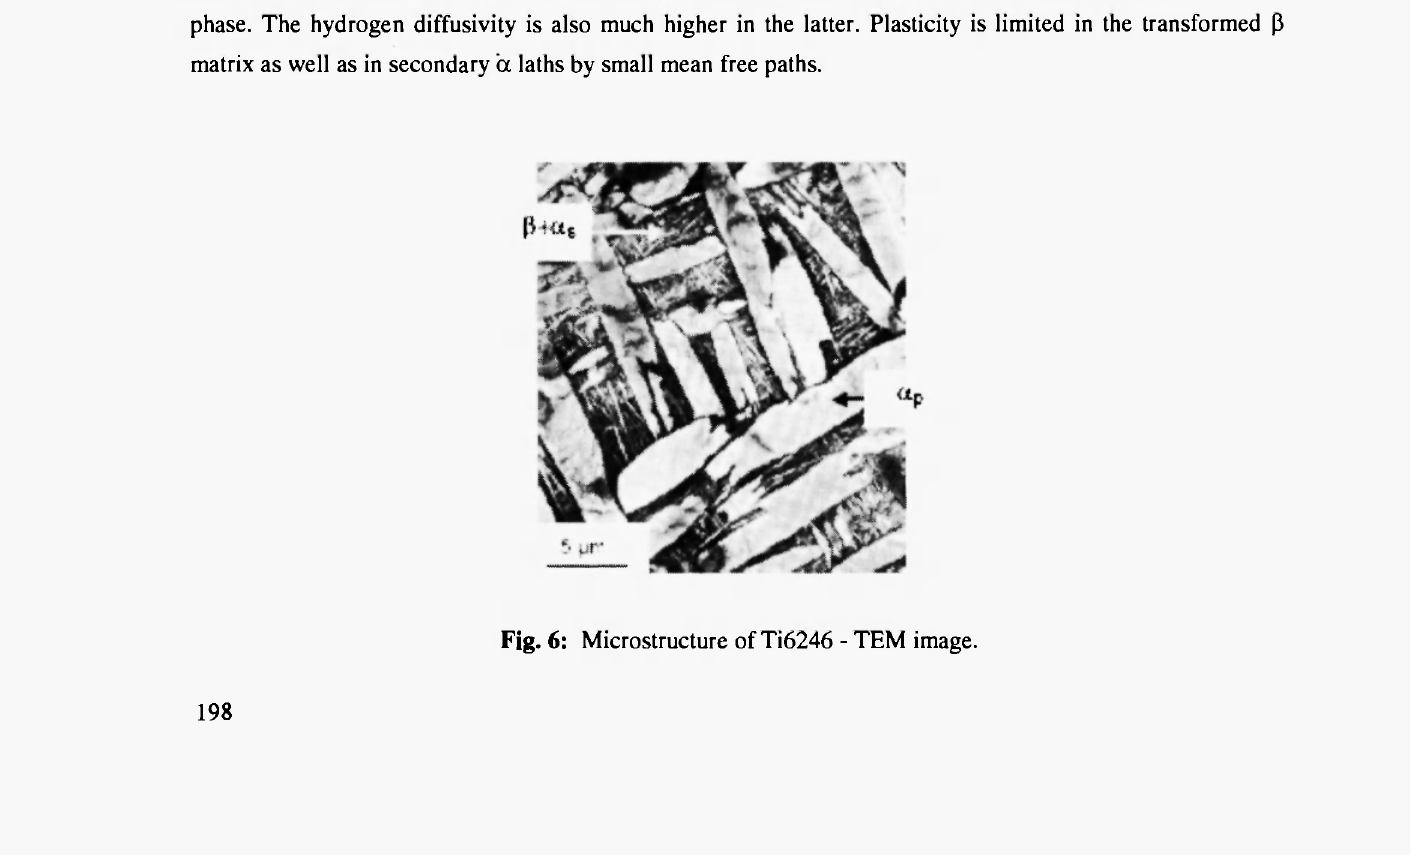
Fig. 6: Microstructure of Ti6246 - TEM